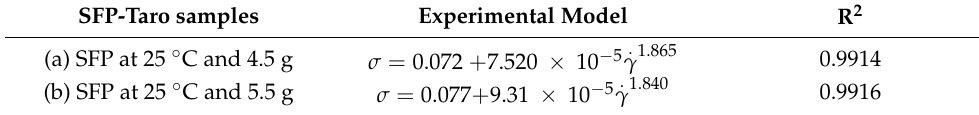
Table 5. Taro SFP HB model at the two levels of starch concentration and 25 °C.